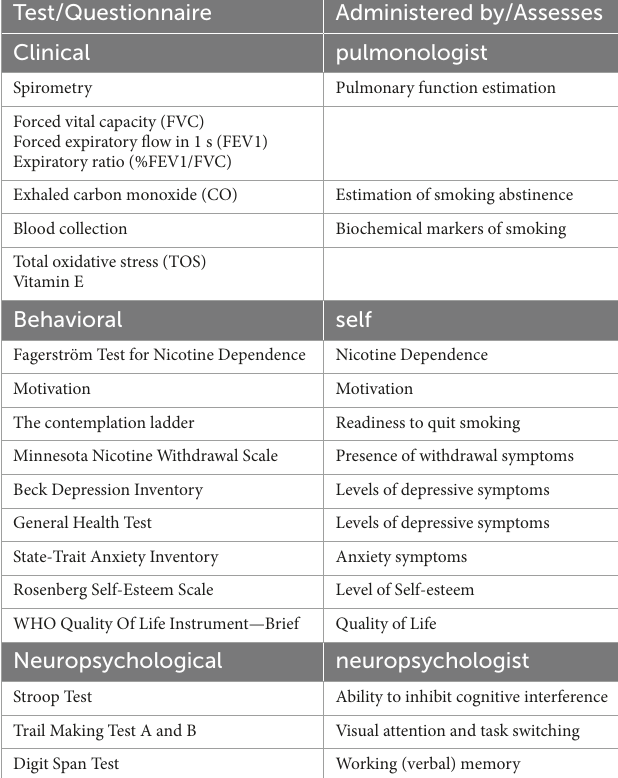
TABLE 1 Overview of clinical, behavioral, and neuropsychological evaluation used in the three stages of the study.